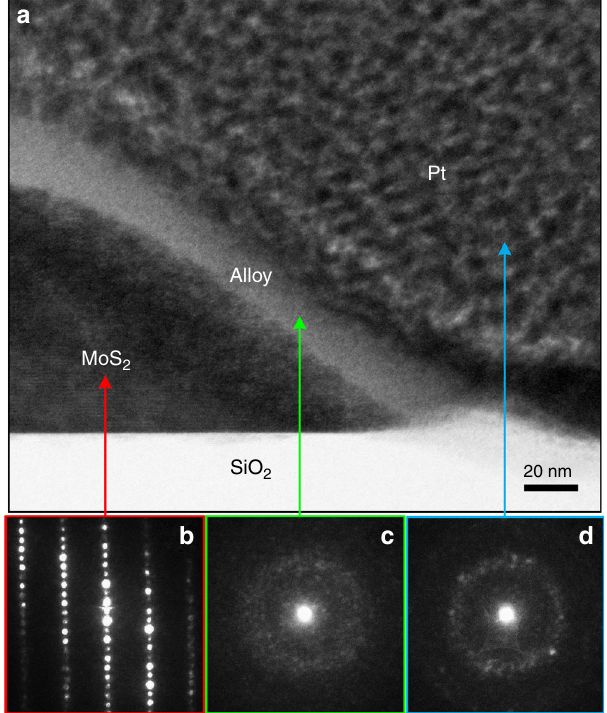
Fig. 5 TEM characterization of Pt/MoS 2 interface. a TEM image focusing on the metal contact of the Pt/MoS 2 interface in an FIB-fabricated MoS 2 nano fl ake device. The corresponding SAED patterns taken from the regions of b MoS 2 , c alloy layer, and d Pt metal are also